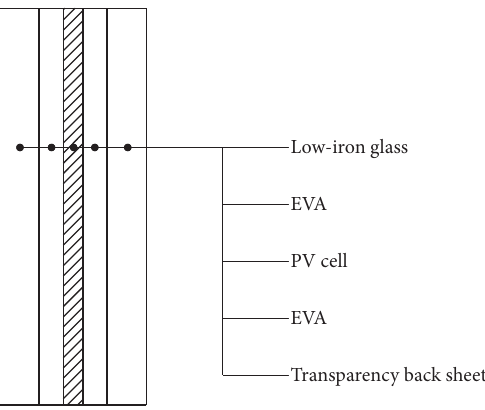
Figure 5: Schematic sketch (not to scale) showing the bifacial PV module configuration.